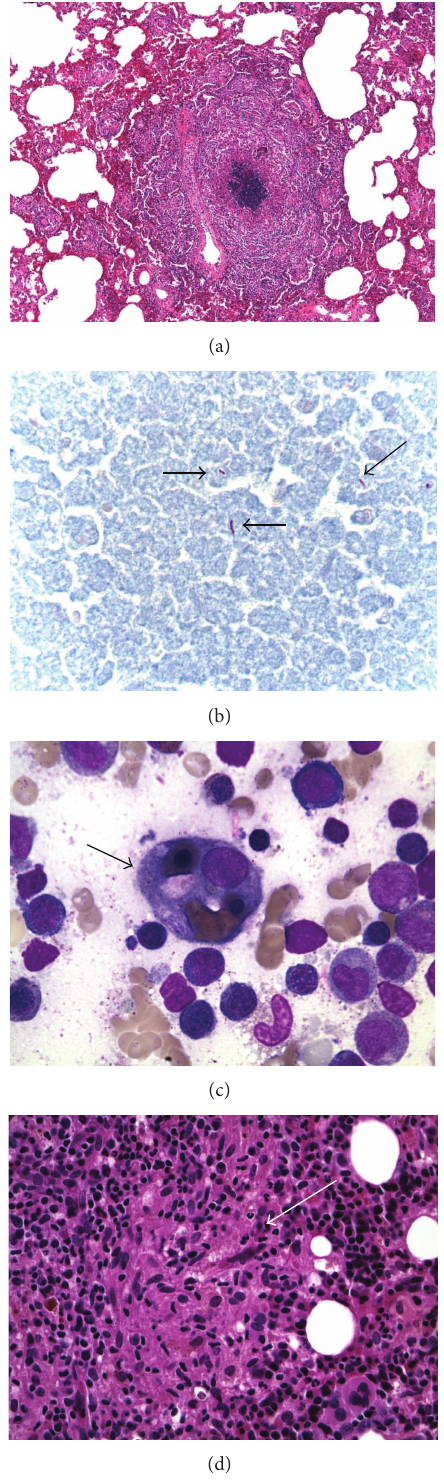
Figure 2: (a) Necrotizing granuloma evident on wedge-resected lung tissue. (b) Ziehl-Neelsen stain revealing acid-fast bacilli in resected lung tissue, consistent with mycobacteria (arrows). (c) Bone marrow aspirate specimen showing a hemophagocyte con- taining erythrocytes and pronormoblasts (arrow) (Wright stain, 1000x). (d) Core bone marrow showing a loose Granuloma (arrow) (Hematoxylin-Eosin stain,